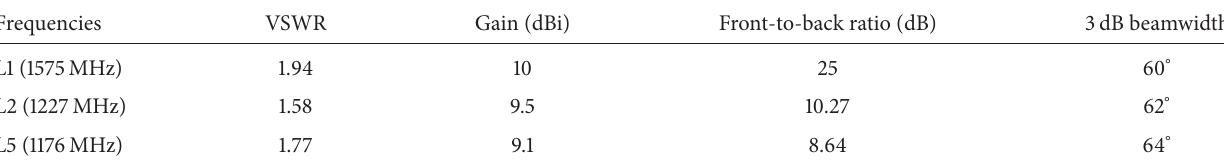
Table 5: Properties of the proposed helical antenna above ground plane.